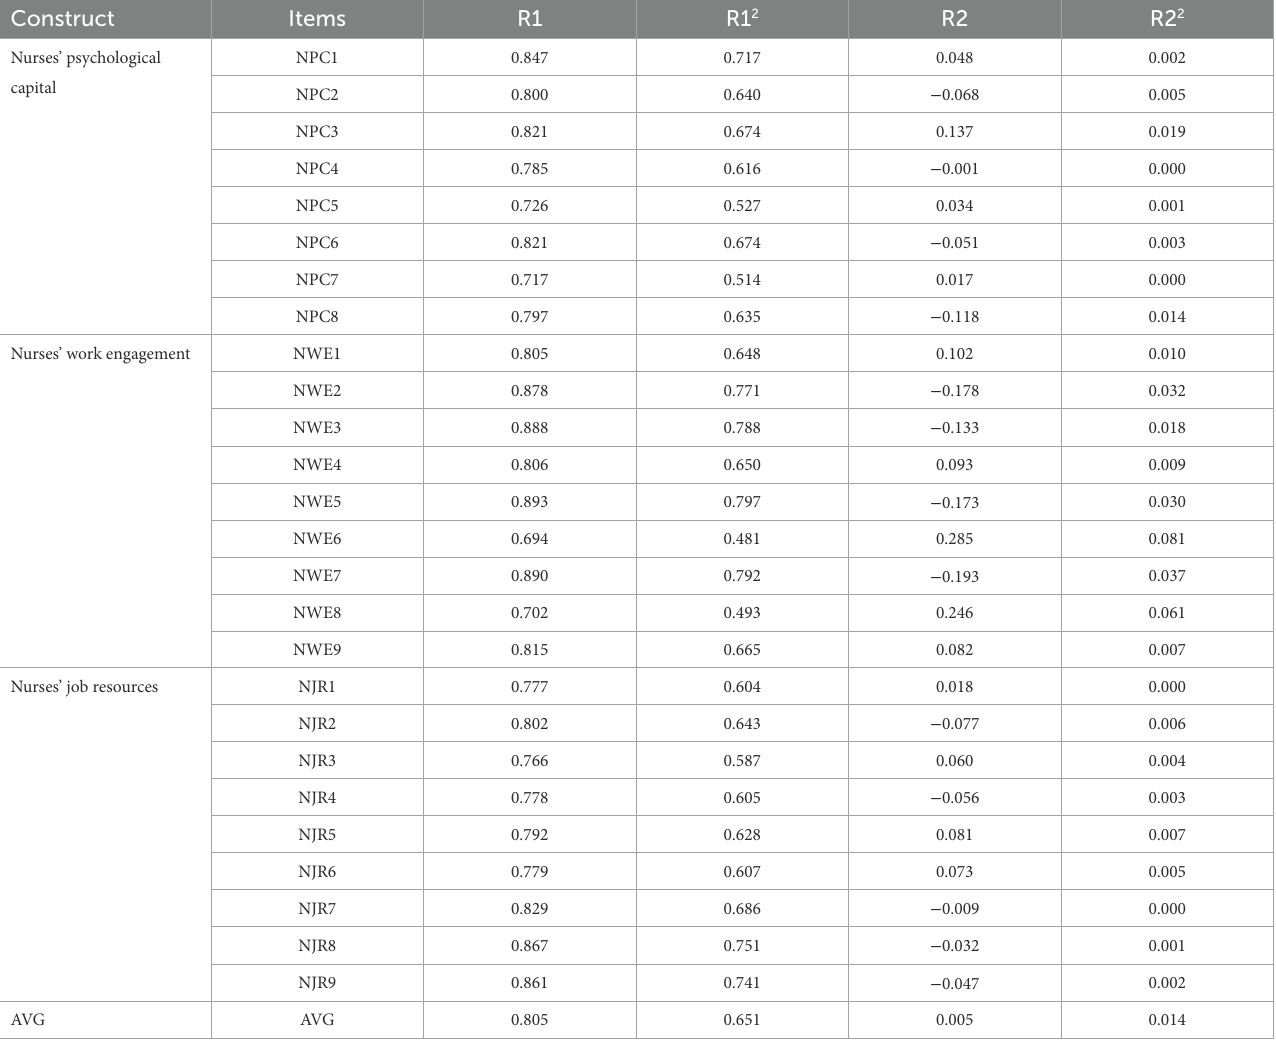
TABLE 2 The result of common method bias test.